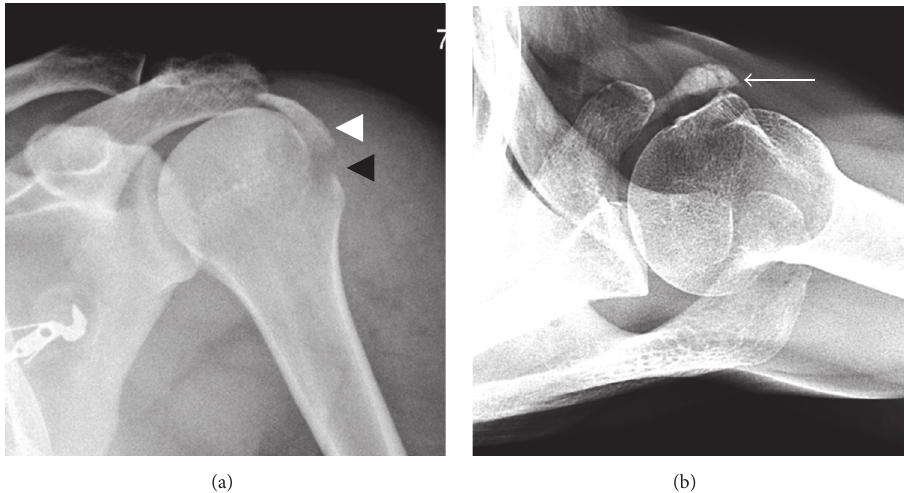
Figure 18:Fracturemimicking calcific tendinitis. (a)Alarge displaced avulsion fractureof thegreater tuberosityispresent (whitearrowhead). The avulsion somewhat resembles calcific tendinopathy, although incomplete cortication of the avulsion fragment in addition to an adjacent donor site (black arrowhead) allows the diagnosis of avulsion fracture to be made. (b) Calcific tendinopathy of the subscapularis (arrow) resembling an avulsion of the rotator cuff. However, calcific tendinopathy has a rounded and more amorphous appearance of the calcification with no fracture donor site being